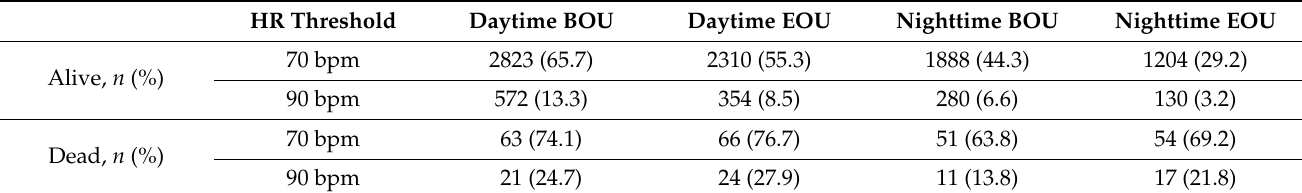
Table 3. Patient outcome with different threshold levels.